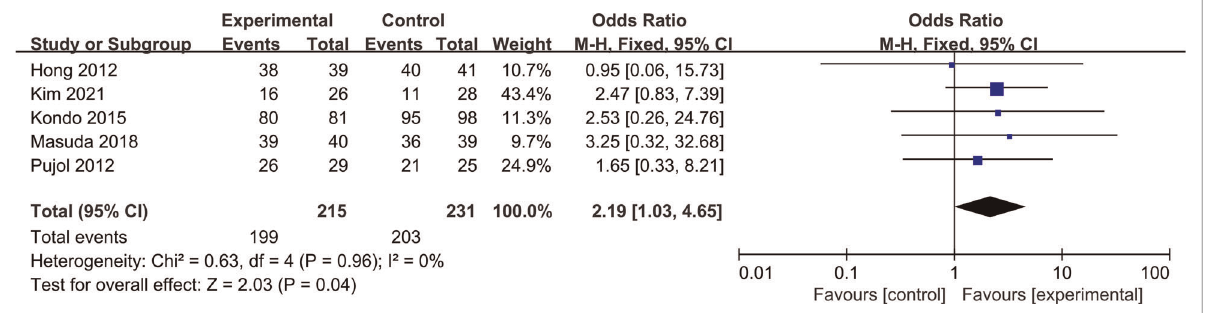
FIGURE 5 Forest pot for IKDC grade.